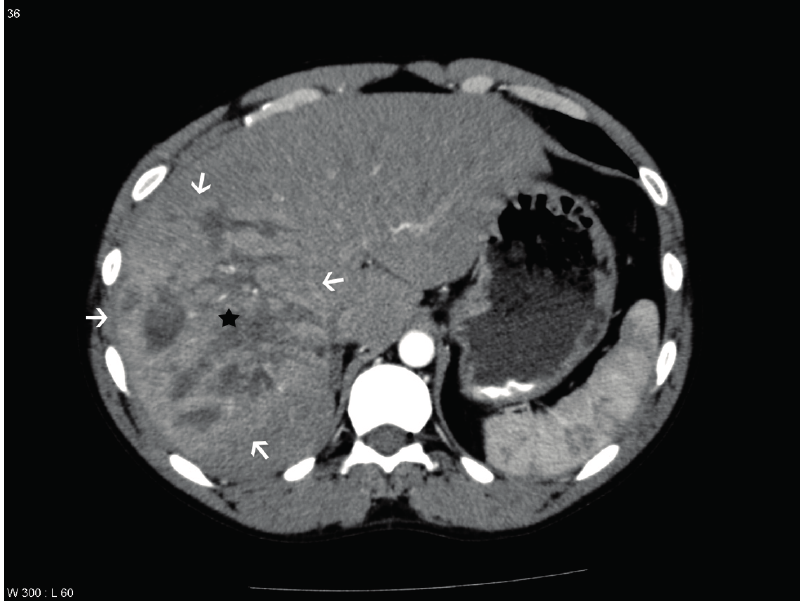
Figure 2. Patient with a liver lesion in segment 4a, 7 and 8. THAD is seen in the periphery of the lesion. PS/AF was not suspected and DSA was not performed. The liver lesion is marked with a black star and the areas with THAD are marked with white